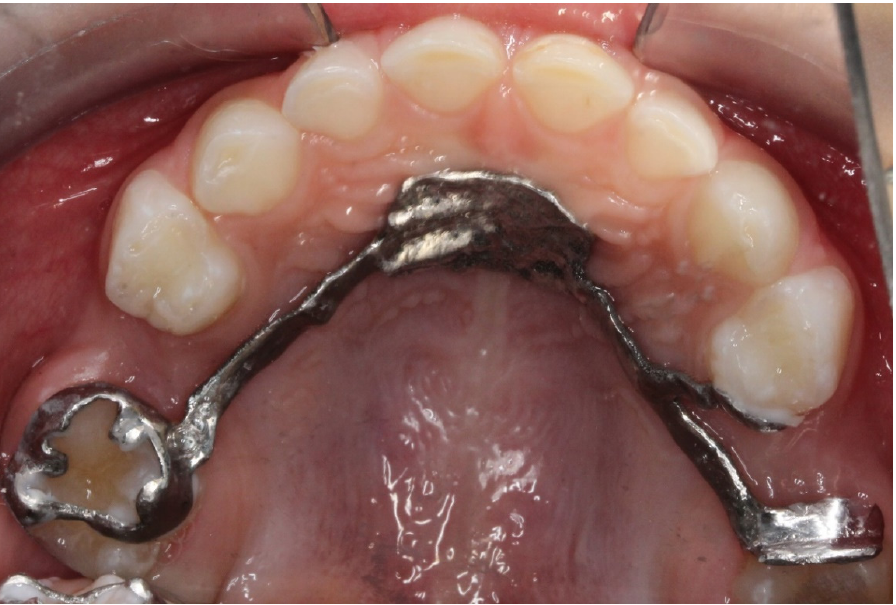
Figure 5. An unerupted molar eruption Nance hybrid guiding appliance. The appliance was inserted prior to molar eruption in order to guide its eruption .